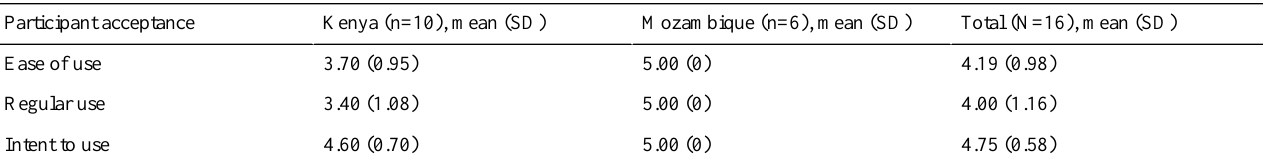
Table 1. The mean (SD) of participant acceptance of mobile phone–based prevention of mother-to-child HIV transmission cascade analysis tool (N=16).